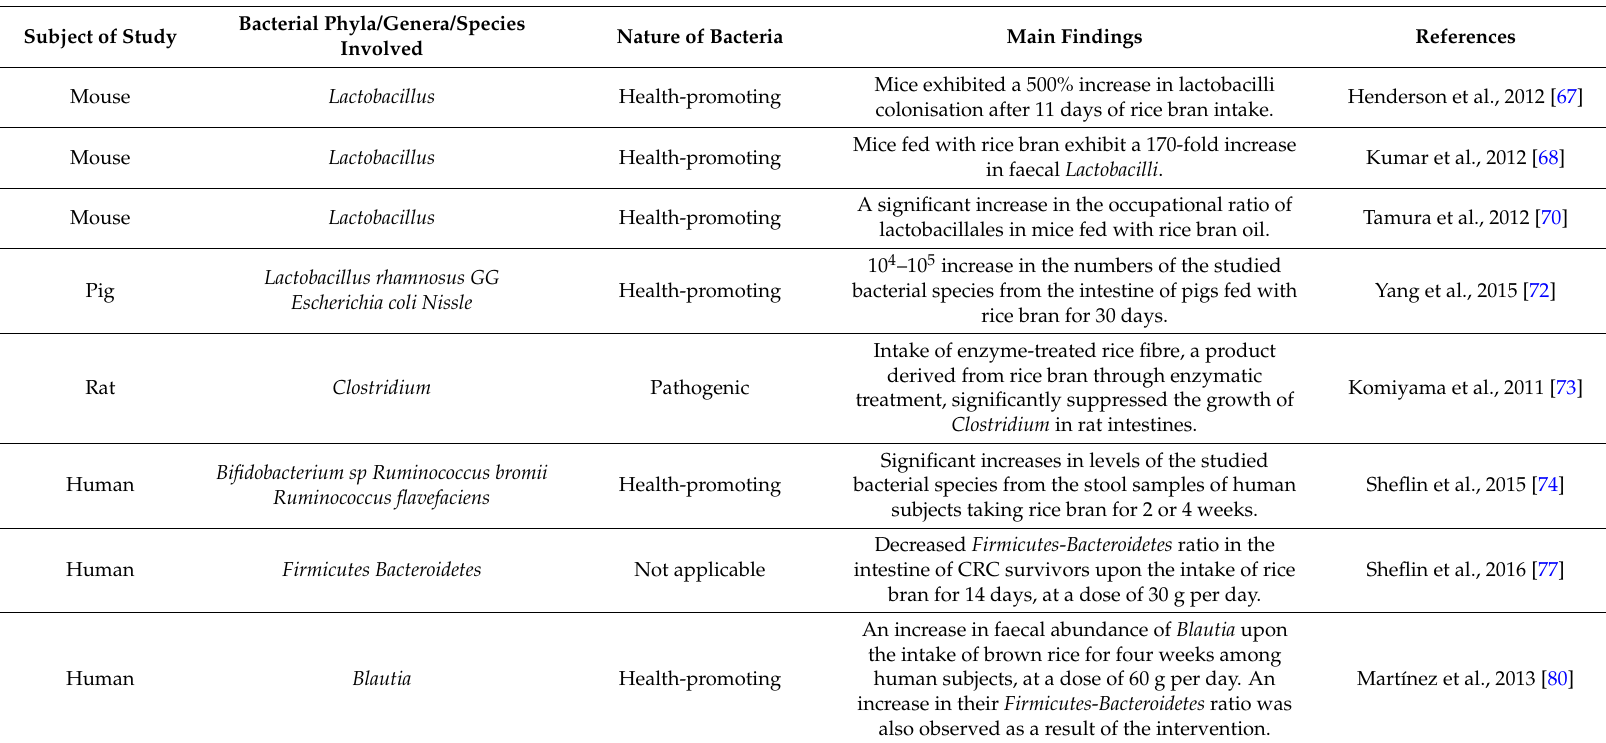
Table 1. A summary of evidence that rice bran intake can lead to a change in the composition of intestinal